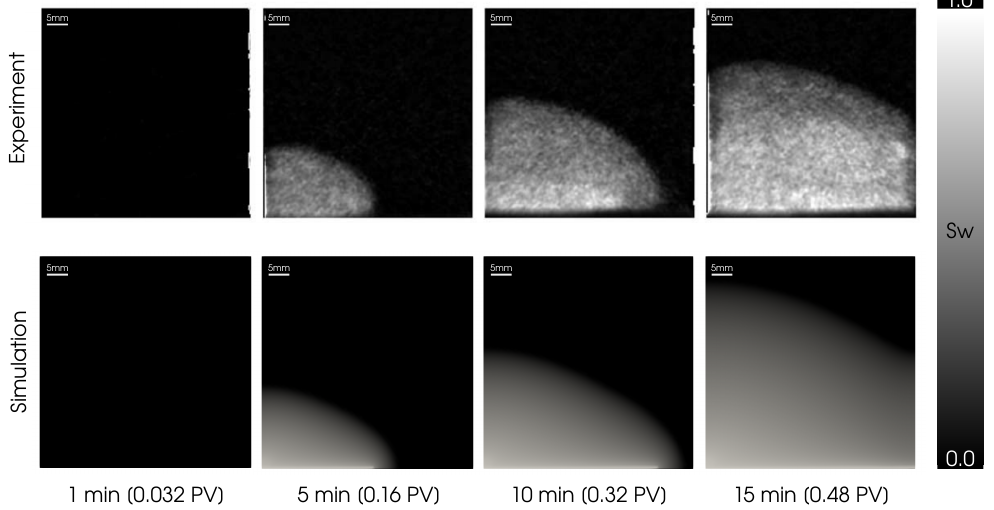
Figure 12. Model CUBE: comparison between physical experiment and simulation. Experiment (( top )—Rangel-German and Kovscek [25]) and simulation ( bottom ). The displacement front is shown for different pore volumes injected (PV). The light colour indicates water.